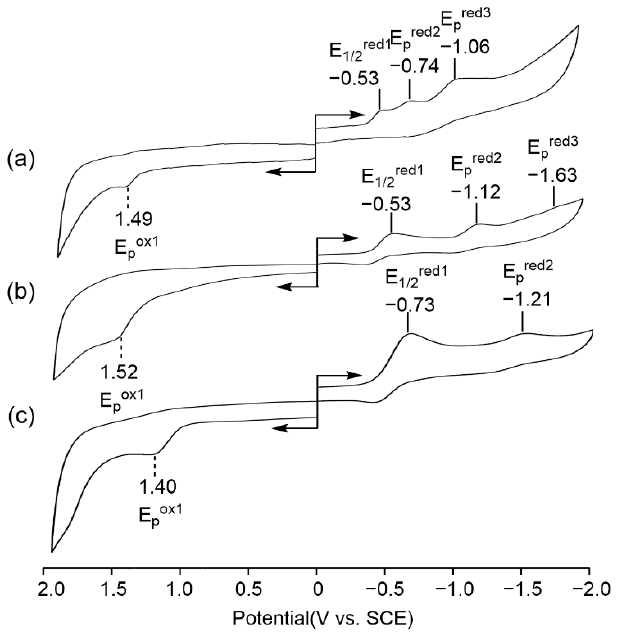
Figure 2. X-ray crystal structure of 6 : ( a ) top view and ( b ) side view. The thermal ellipsoids are scaled to the 50% probability level.